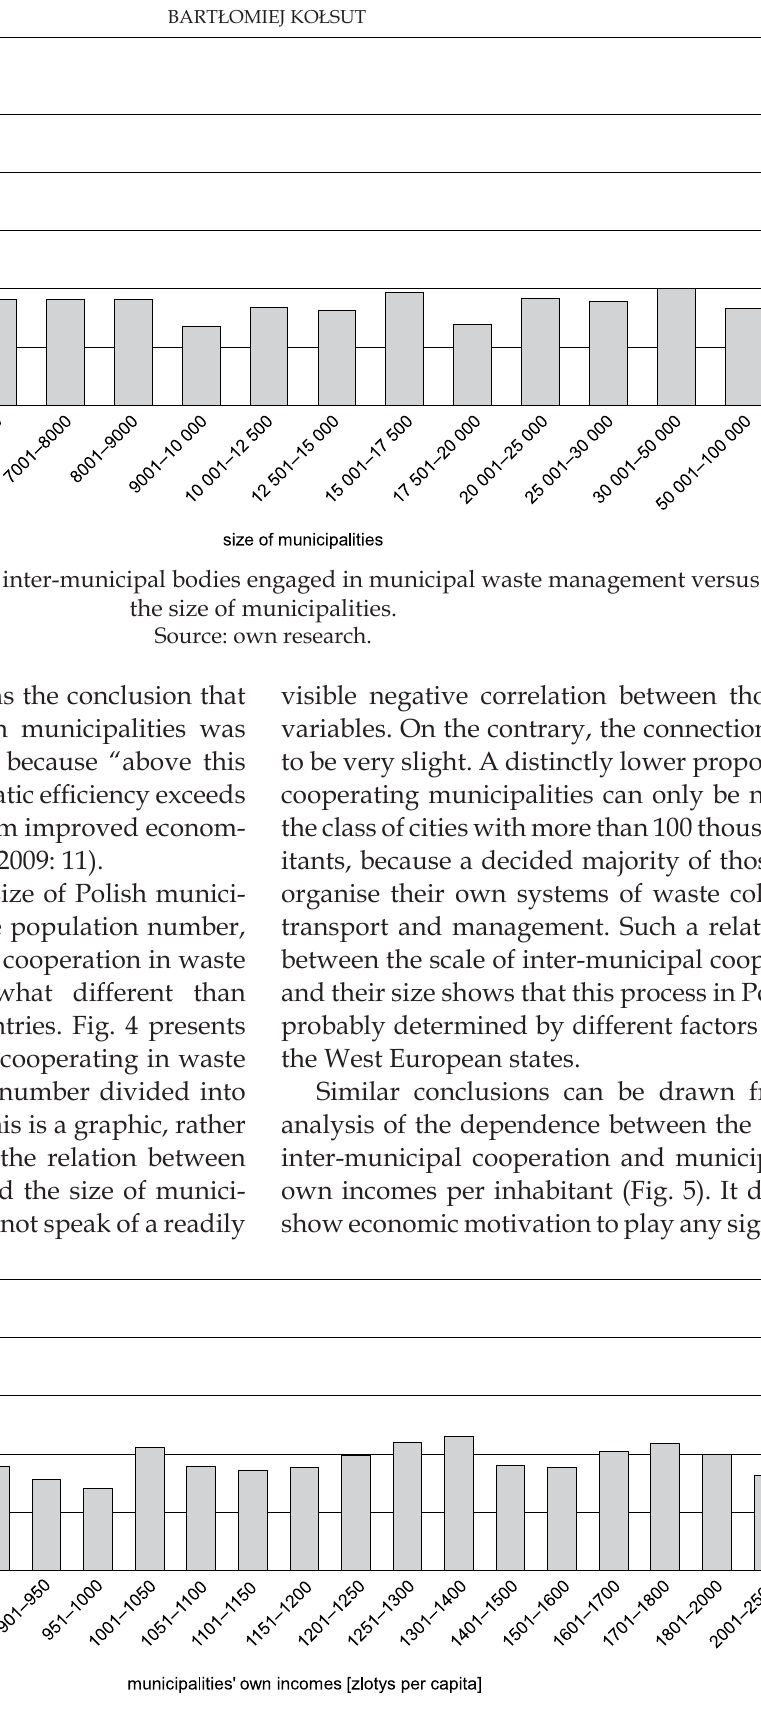
Fig. 5. Inter-municipal cooperation and municipalities’ own incomes. Source: own research.